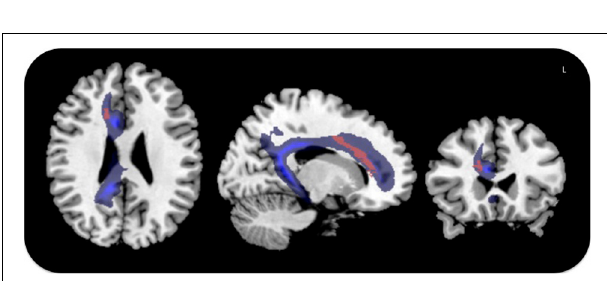
might well contribute to the presence and severity of MN in some cases, by impairing patients’ ability to direct their attention toward their contralesional